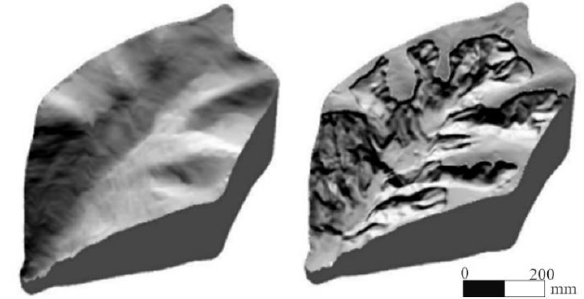
Figure 1 . study area. left and right are 1st and 9th DEM, respectively.